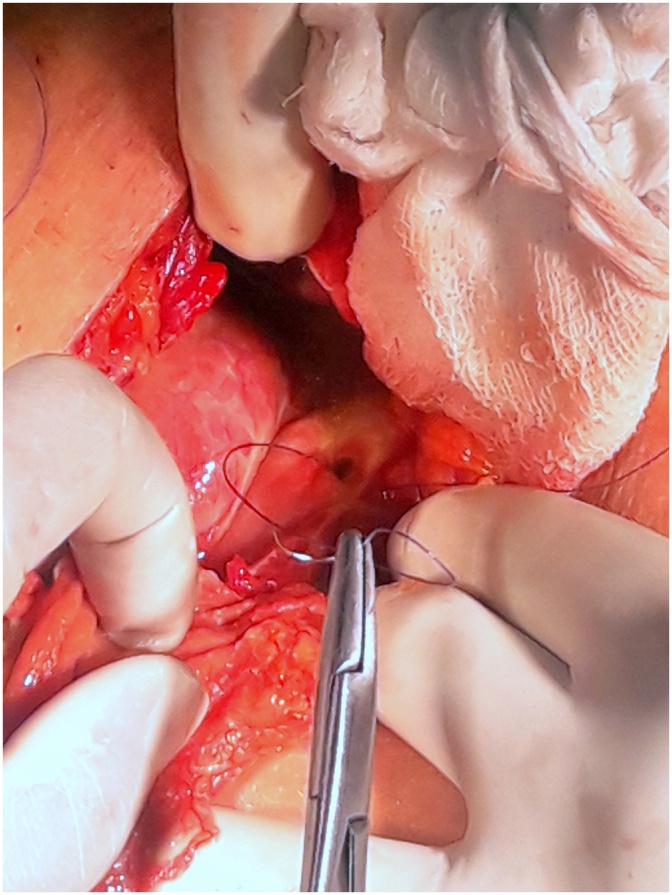
0.5 × 0.5 cm gastric antrum perforation with stay suture in place.